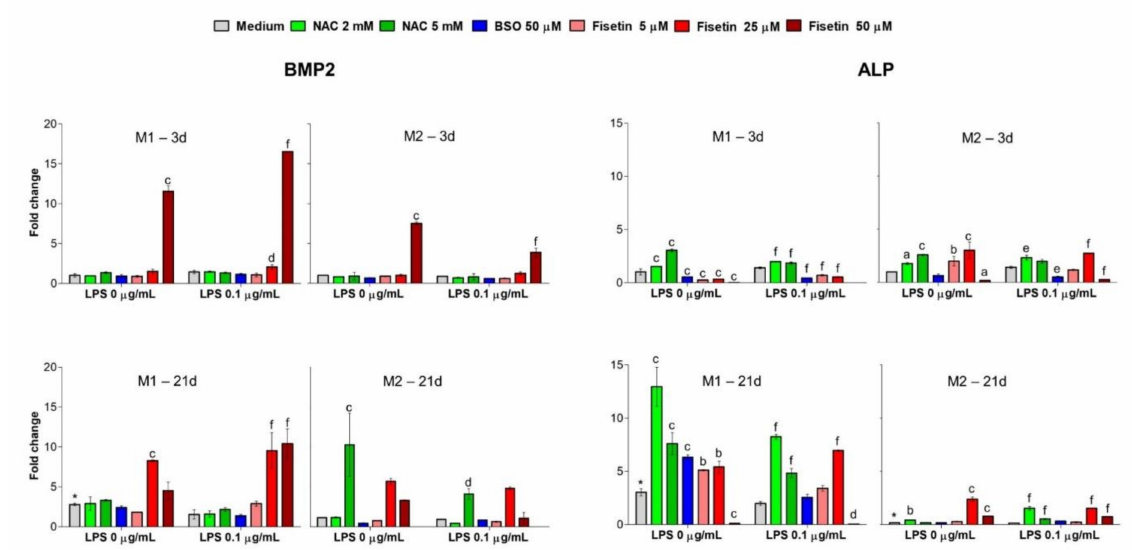
Figure 5. Gene expression of bone morphogenic protein 2 (BMP2) and alkaline phosphatase (ALP) in the various experimental conditions. Bars represent delta CT-values of gene expression as mean values ± standard deviations normalized to RPS18 expression. Data presented are summarized